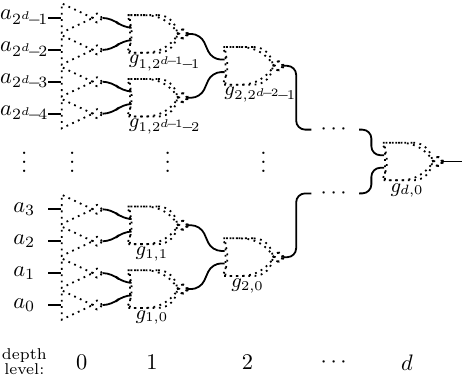
Figure 2: General structure for implementing a function with latency complexity d